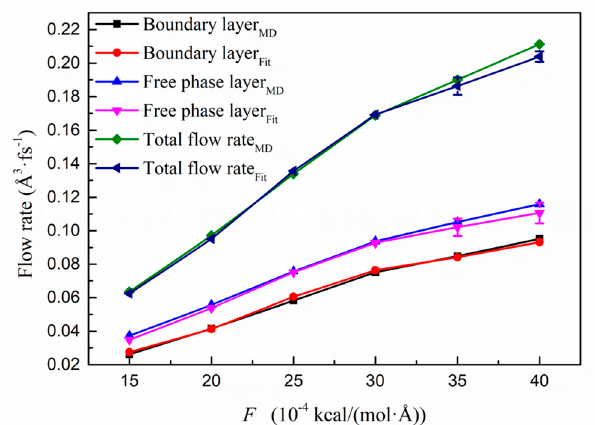
Figure 9. The segmentation fitting of the fluid flow rate (half of the fluid) at different driving forces. T = 300 K. Some error bars are smaller than the scatter size.